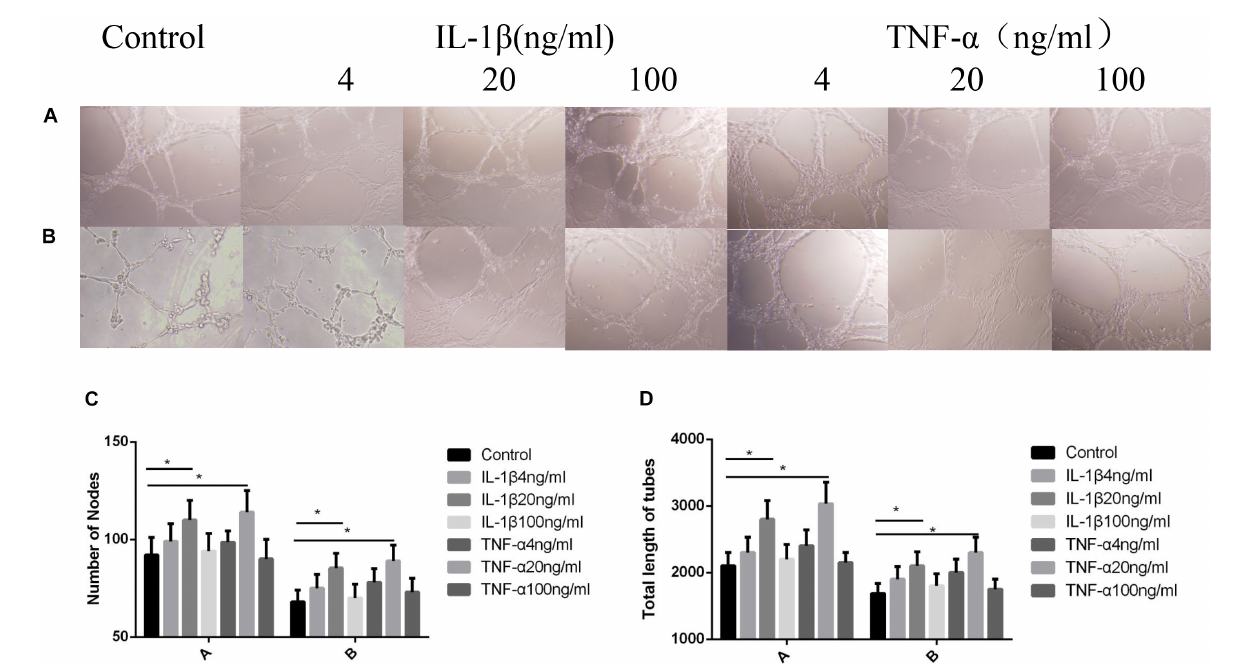
FIGURE 3 | Influences exerted by IL-1 β and TNF- α on vascular endothelial cell angiogenesis. Mean ± standard deviation (SD) denote the experimental results; * indicates P < 0.05. (A) Samples without P311 siRNA intervention. (B) Samples with P311 siRNA intervention. (C) Number of blood vessels corresponding to A and B . (D) Length of blood vessels in correspondence to A and B .